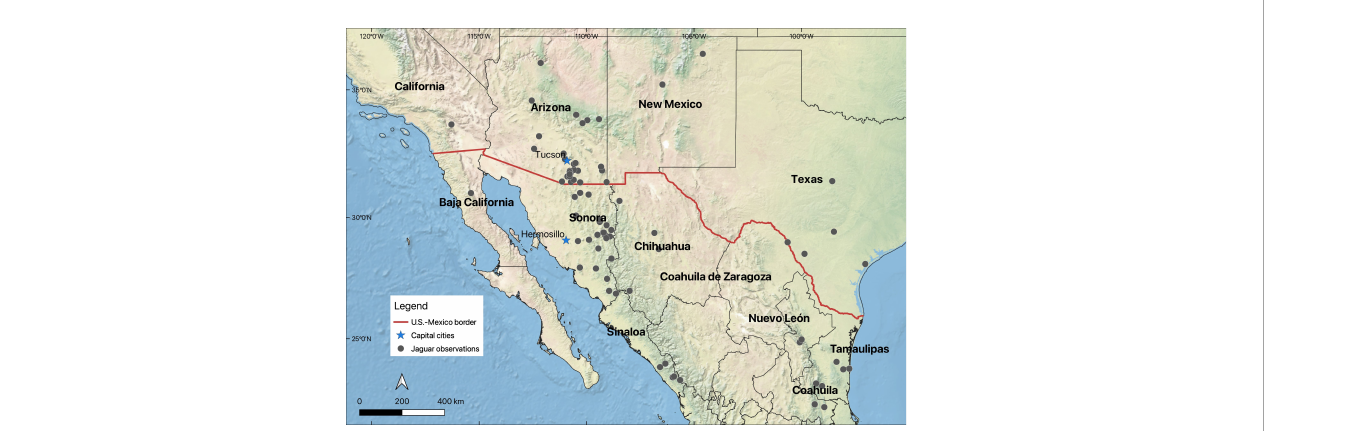
FIGURE 2 Map of the US-Mexico border. The borderlands are typically considered to be the areas within 300 km north and south of the border. Jaguar observation data taken from the public US Fish and Wildlife Service ’ s Jaguar Observation Database (jaguardata.info/#). Observations include fi rst-, second-, and third- hand reports of jaguar presence from the 20 th and 21 st centuries. Created with QGIS